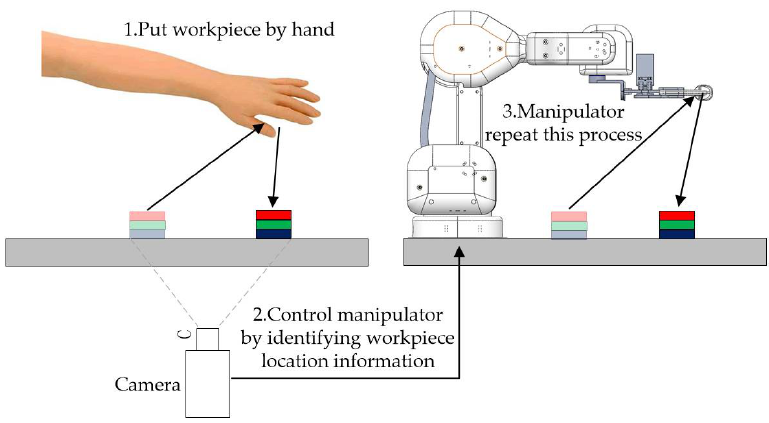
Figure 8. Schematic diagram of the usage of the system. Figure 8 . Schematic diagram of the usage of the system. Figure 8 . Schematic diagram of the usage of the system.